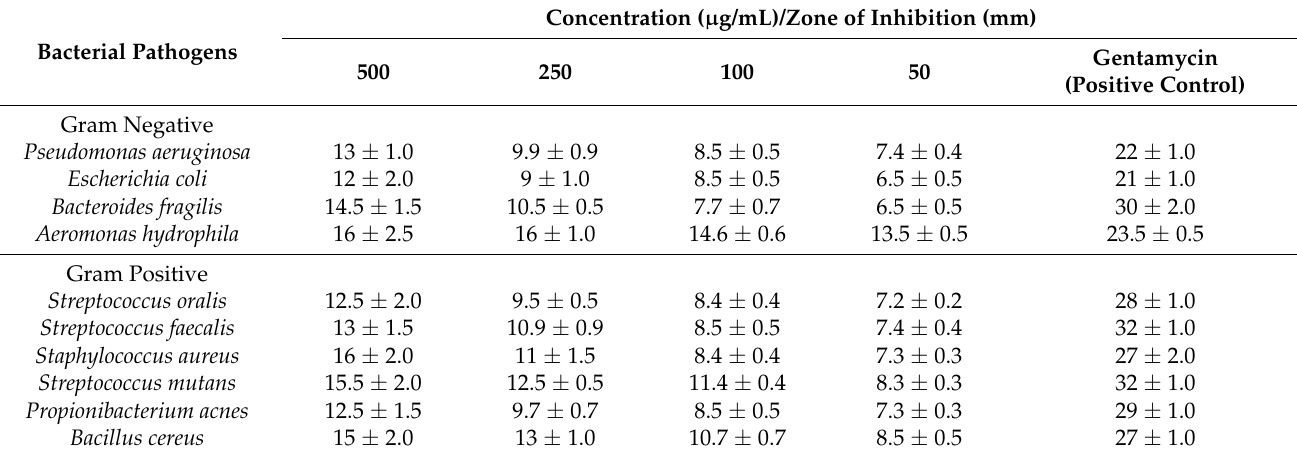
Table 2. Antibacterial activity of ethanol extract of M. annua against number of bacterial